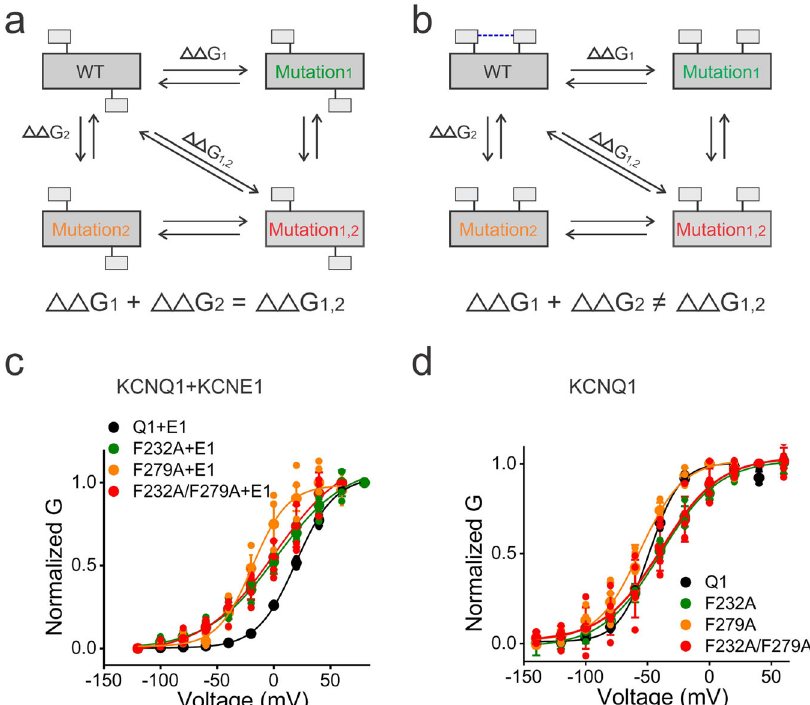
Fig. 6 Mutant cycle analysis suggests that F232 and F279A interact in KCNQ1/KCNE1 channels but not in KCNQ1 channels alone. a If mutant 1 (green) and mutant 2 (orange) are functionally independent of each other, the sum of the free-energy changes of the two single mutants will be equal to the free- energy change of double mutant 1,2 (red). b If mutant 1 (green) and mutant 2 (orange) are functionally interacting with each other (indicated as a blue dashed line), the sum of the free-energy changes of the two single mutants will be not equal to the free-energy change of double mutant 1,2 (red). c Voltage dependence of current activation from KCNQ1 + KCNE1 (black, n = 4), KCNQ1-F232A/KCNE1 (green, n = 4), KCNQ1-F279A/KCNE1 (orange, n = 3), and KCNQ1-F232A-F279A/KCNE1 (red, n = 5) channels. d Voltage dependence of current activation from KCNQ1 (black, n = 4), KCNQ1-F232A (green, n = 3), KCNQ1-F279A (orange, n = 4), and KCNQ1-F232A-F279A (red, n = 5) channels without KCNE1 association. The voltage protocol is indicated in Fig. 2. Data are shown as mean ±